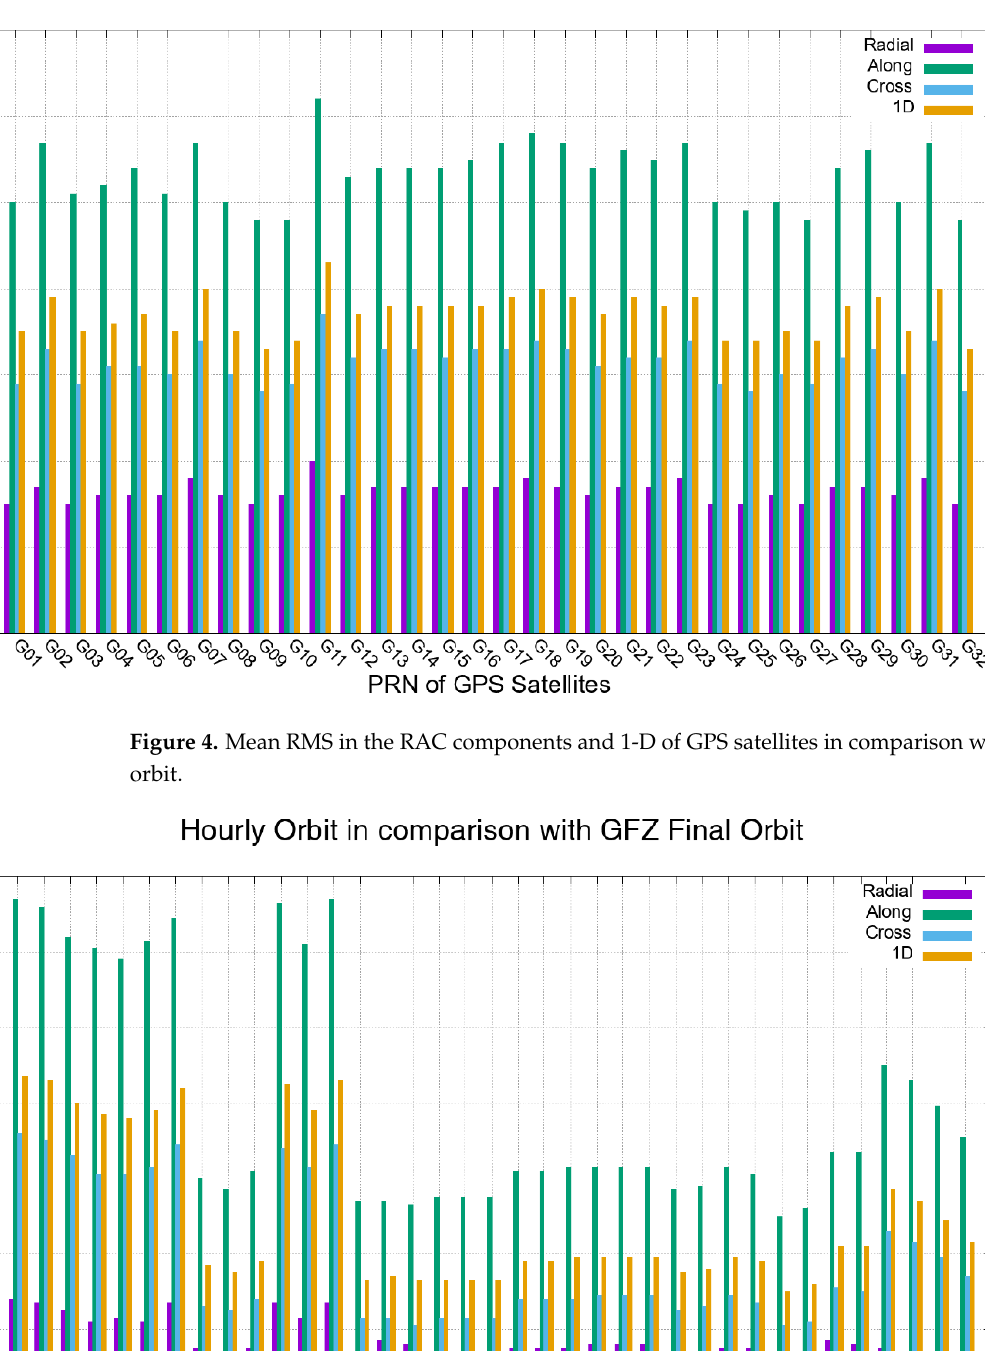
Figure 6. Mean RMS in the RAC components and 1-D of GLONASS satellites in comparison with GFZ final orbit.